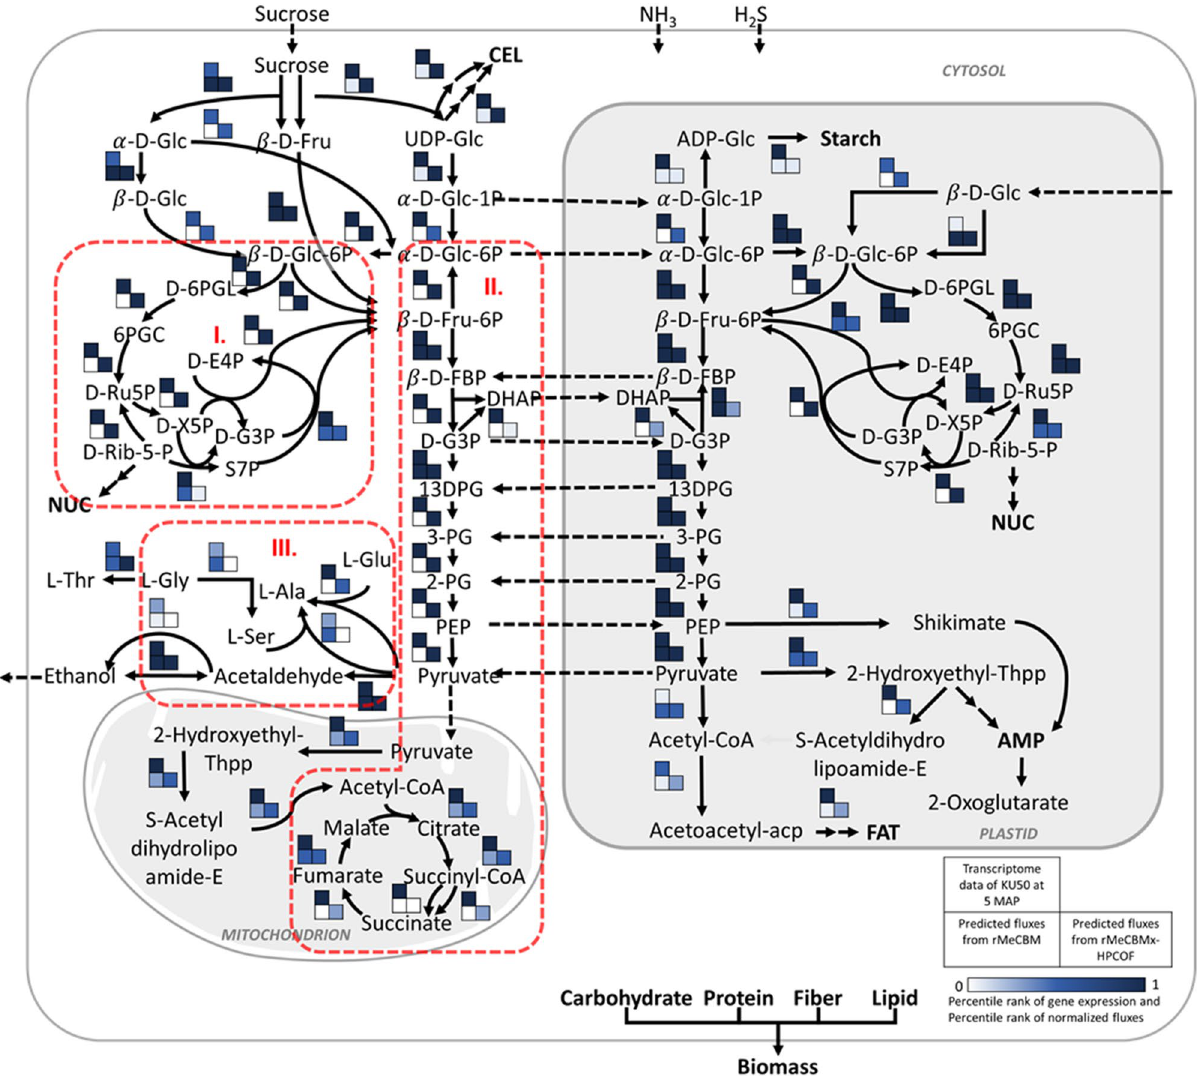
Figure 6. The comparison of ranked gene expression levels (top cell) with ranked fluxes from rMeCBM (left bottom cell) and rMeCBMx-HPCOF (right bottom cell) as shown in the heatmap; the color represents relative levels of gene expression and fluxes with a score of 0–1. The improvement of rMeCBMx-HPCOF prediction is linked to (I) carbon substrates supply via pentose phosphate pathway, (II) TCA cycle and glycolysis, (III) carbon precursors for alanine